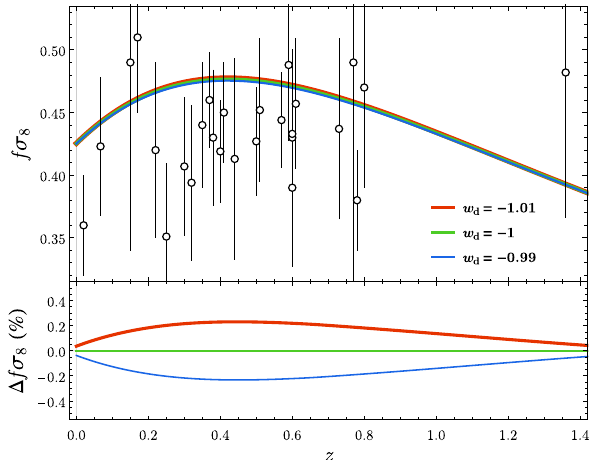
Fig. 3 (Top panel) evolution of f σ 8 for low red-shift z ∈ ( 0 , 1 . 4 ) for three dark energy models: (blue) w = − 0 . 99, (green) w = − 1 and (red) w = − 1 . 01. White circles and vertical bars indicate the available data points and corresponding error bars (cf. Table I of [22]). (Bottom panel) Evolution of the relative differences of f σ 8 for each model with regard to Λ CDM ( w = − 1). Δ f σ 8 is positive in the phantom case and negative in the quintessence case. For all the models, it was considered that σ 8 evolves linearly with δ m and that σ 8 = 0 . 816 at the present